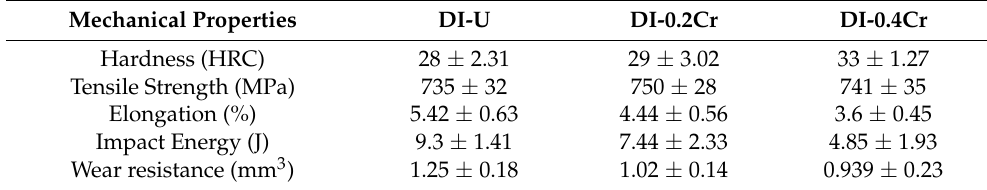
Table 3. Mechanical properties of the ductile irons unalloyed and alloyed with 0.2 and 0.4% Cr. Mechanical Properties